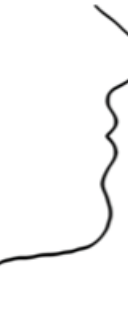
Figure 2. Silhouette of advancement devices post treatment.